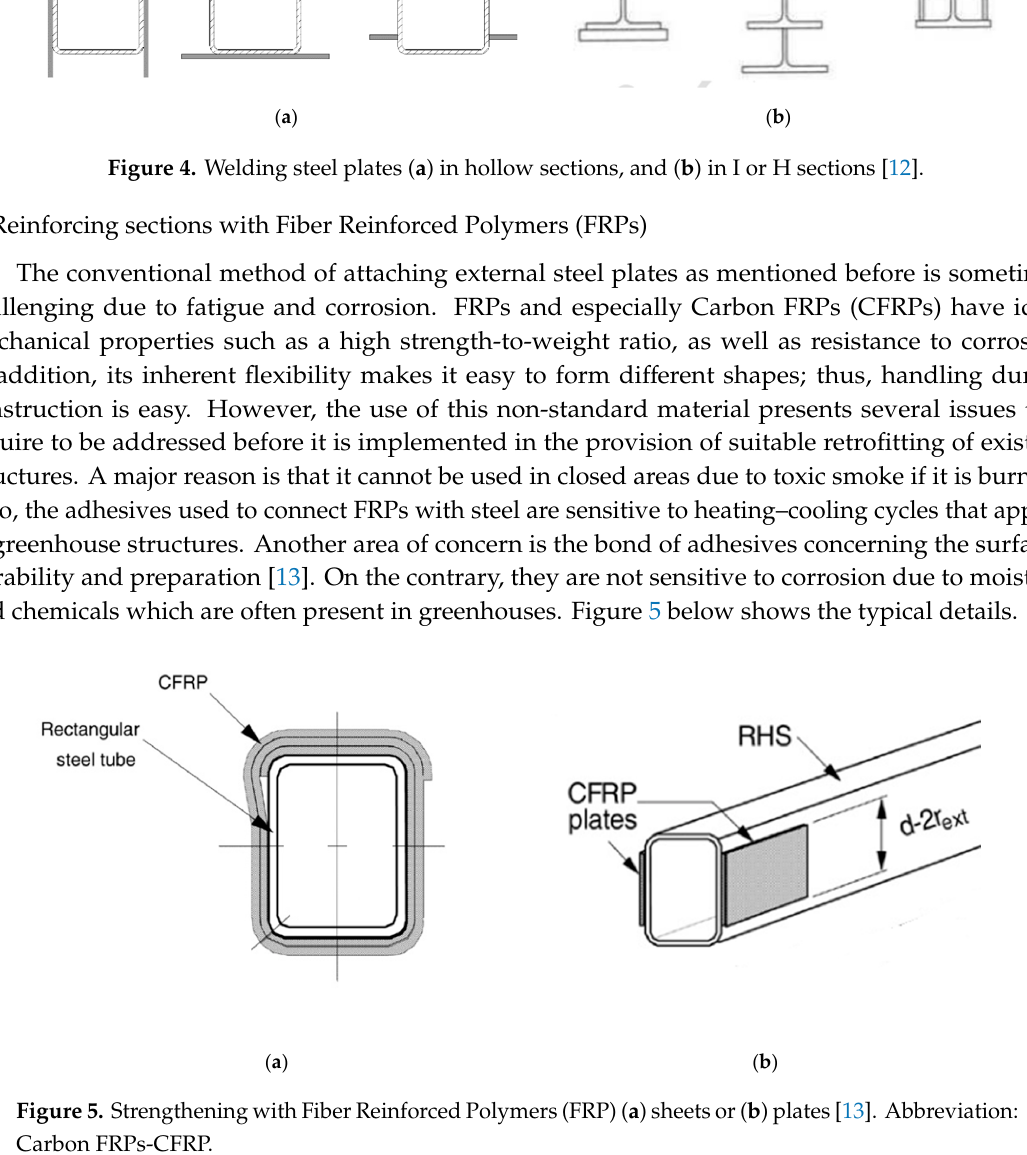
Figure 4. Welding steel plates ( a ) in hollow sections, and ( b ) in I or H sections [12].